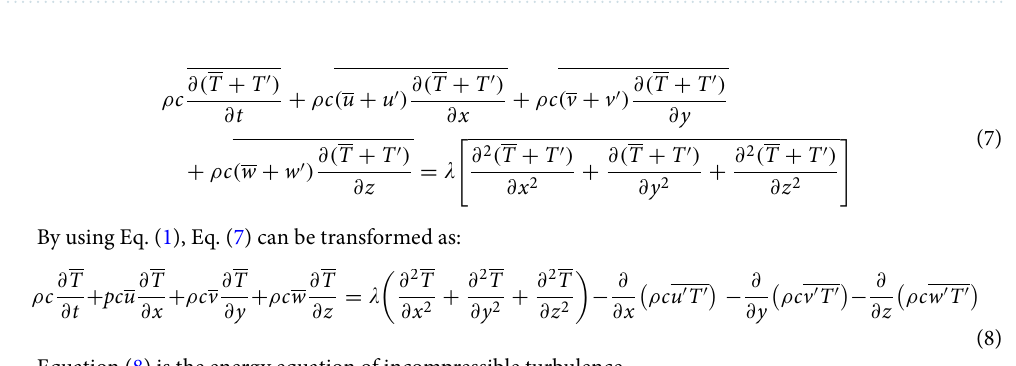
Table 2. K − ε model